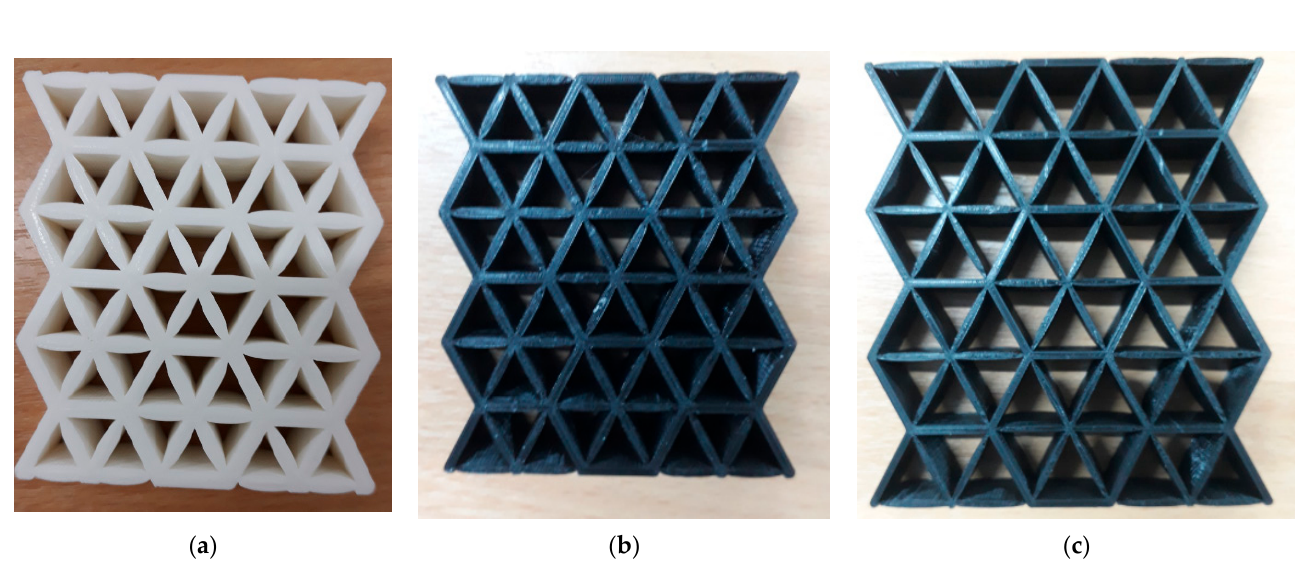
Figure 4. The final 3D printed specimens for ( a ) cell size 20 mm, thickness 2.5 mm, ( b ) cell size 25 mm, thickness 2 mm and ( c ) cell size 30 mm, thickness 1.5 mm.